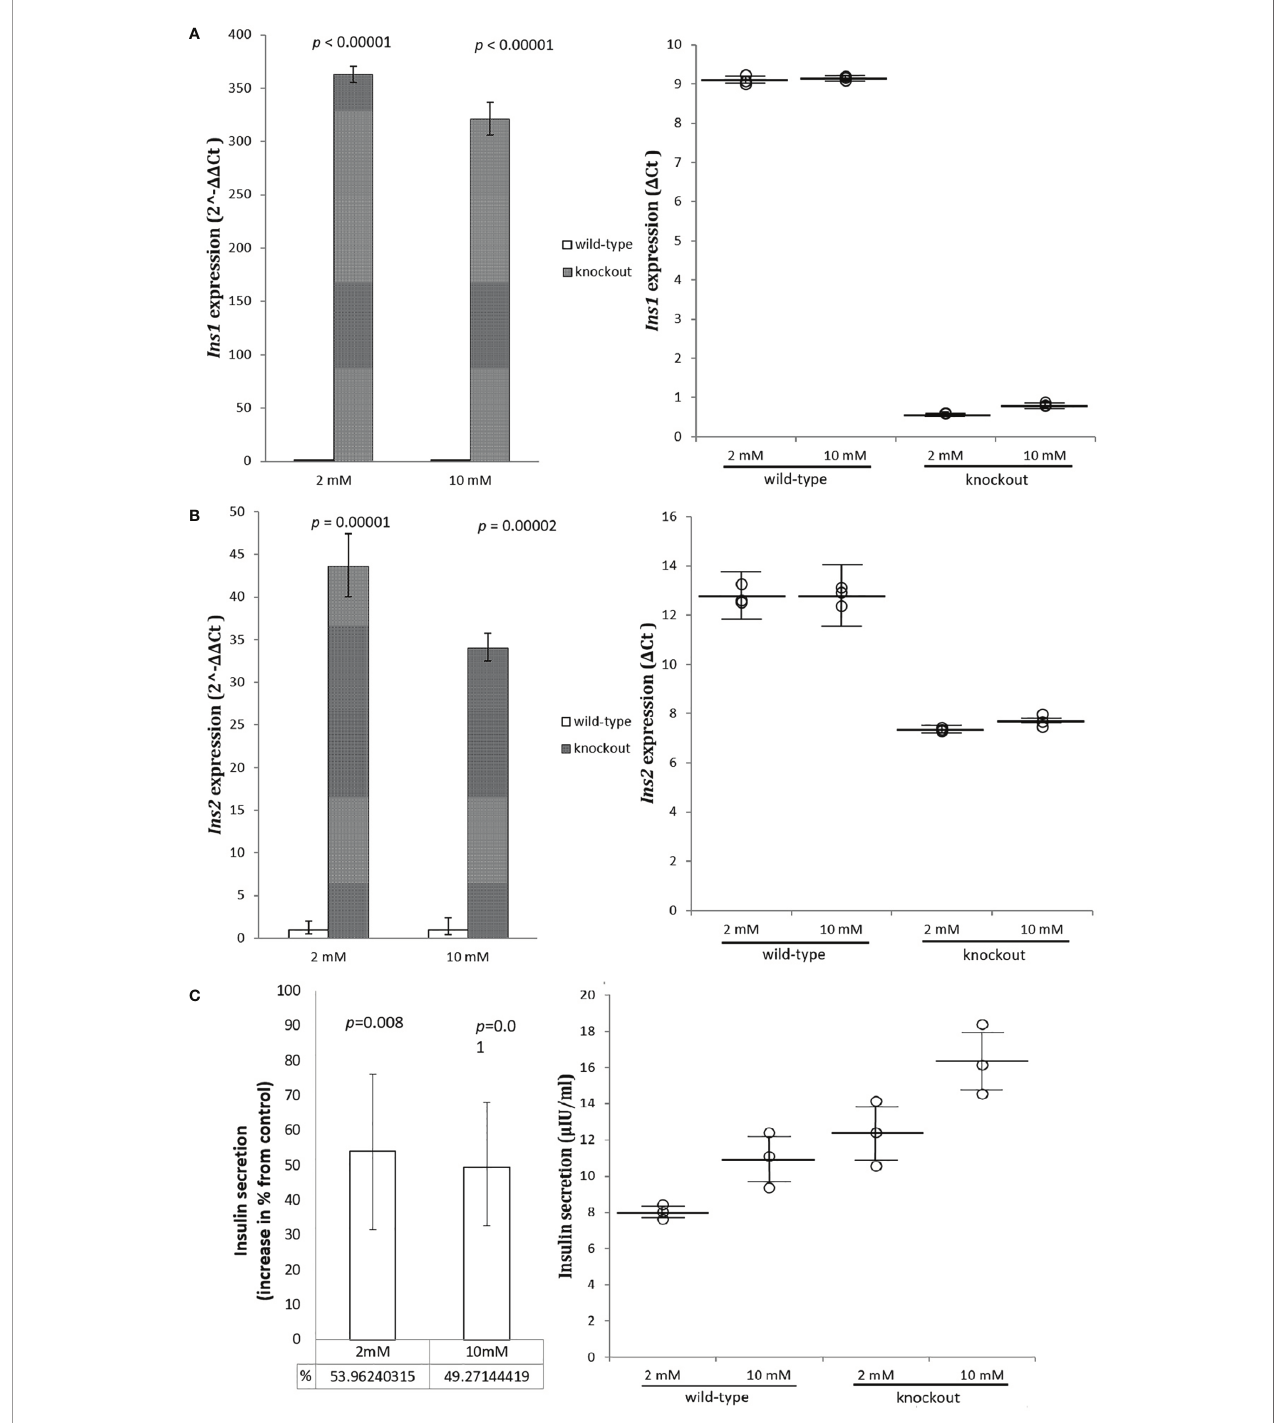
FIGURE 3 | Insulin genes and secretion. RIN-m( -/- Adcy7 ) mRNA level established by quantitative RT-PCR. The CT values were normalized to b -actin to yield D CT and 2^- DD CT values presented in dots and bar chart, respectively. Each dot represents an individual sample, whereas the horizontal lines represent the mean and standard error of the mean. D CT values were then calculated and presented as 2^- DD CT values (fold change) in a bar chart. (A) presents the mRNA level of Ins1 when incubated in low glucose level 2mM and high glucose level 10mM, while (B) shows the expression level of Ins2 under the same condition. (C) illustrates insulin secretion when incubated for one hour with 2mM glucose and 10mM glucose compared to the control. Unpaired t-test with mean of ELISA or delta CT and SE ± values were used for statistic